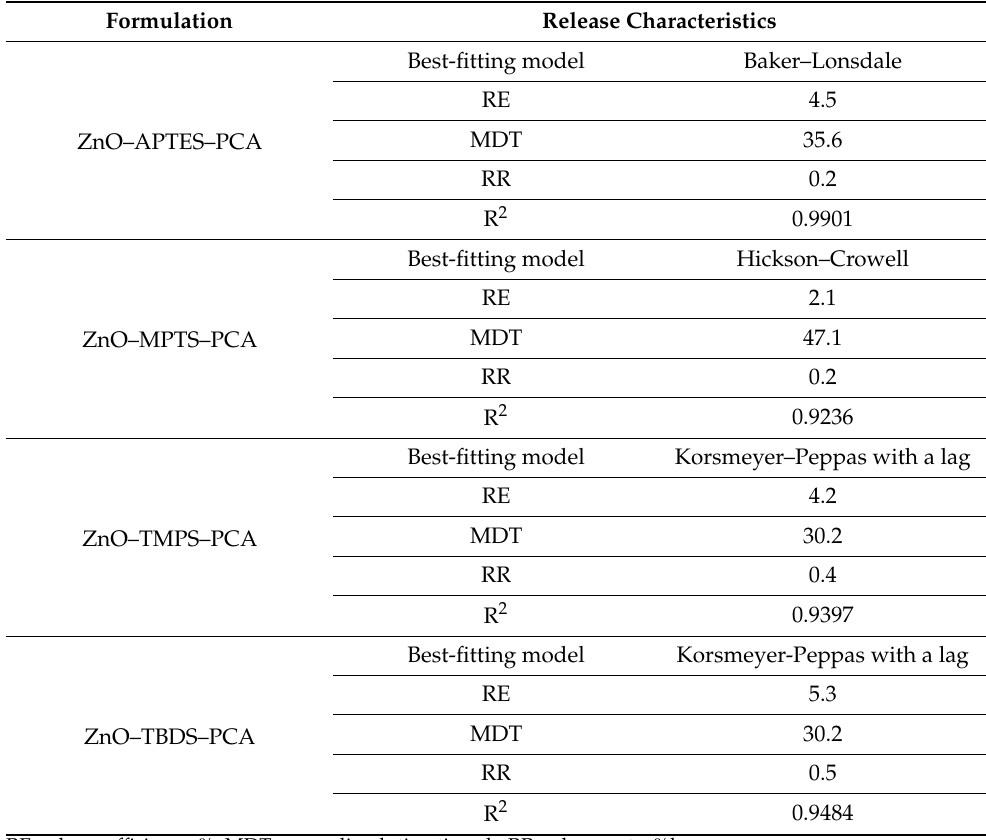
Table 2. In vitro release criteria of PCA released from nanoformulations prepared based on ZnO NPs modified with various organic functionalities in the